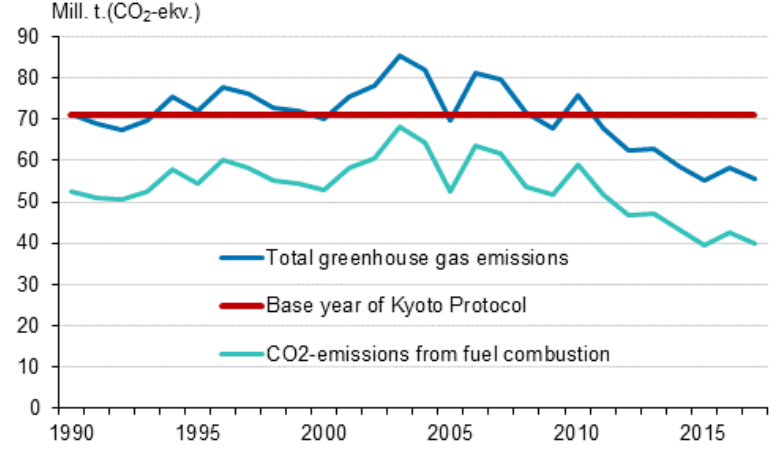
Fig. 3. Development of Finnish GHG emissions (Statistics Finland